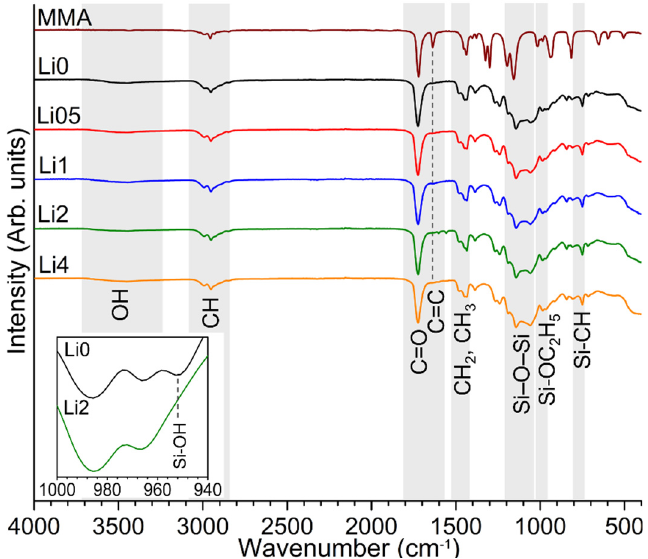
Figure 5. FTIR spectra of the MMA reference and PMMA–silica–Li hybrids modified with lithium carbonate in the concentration range between 0 and 4000 ppm (Li0–Li4). Inset: band at 950 cm − 1 related to Si-OH stretching vibrations observed for Li0 but not present in the Li-containing samples.